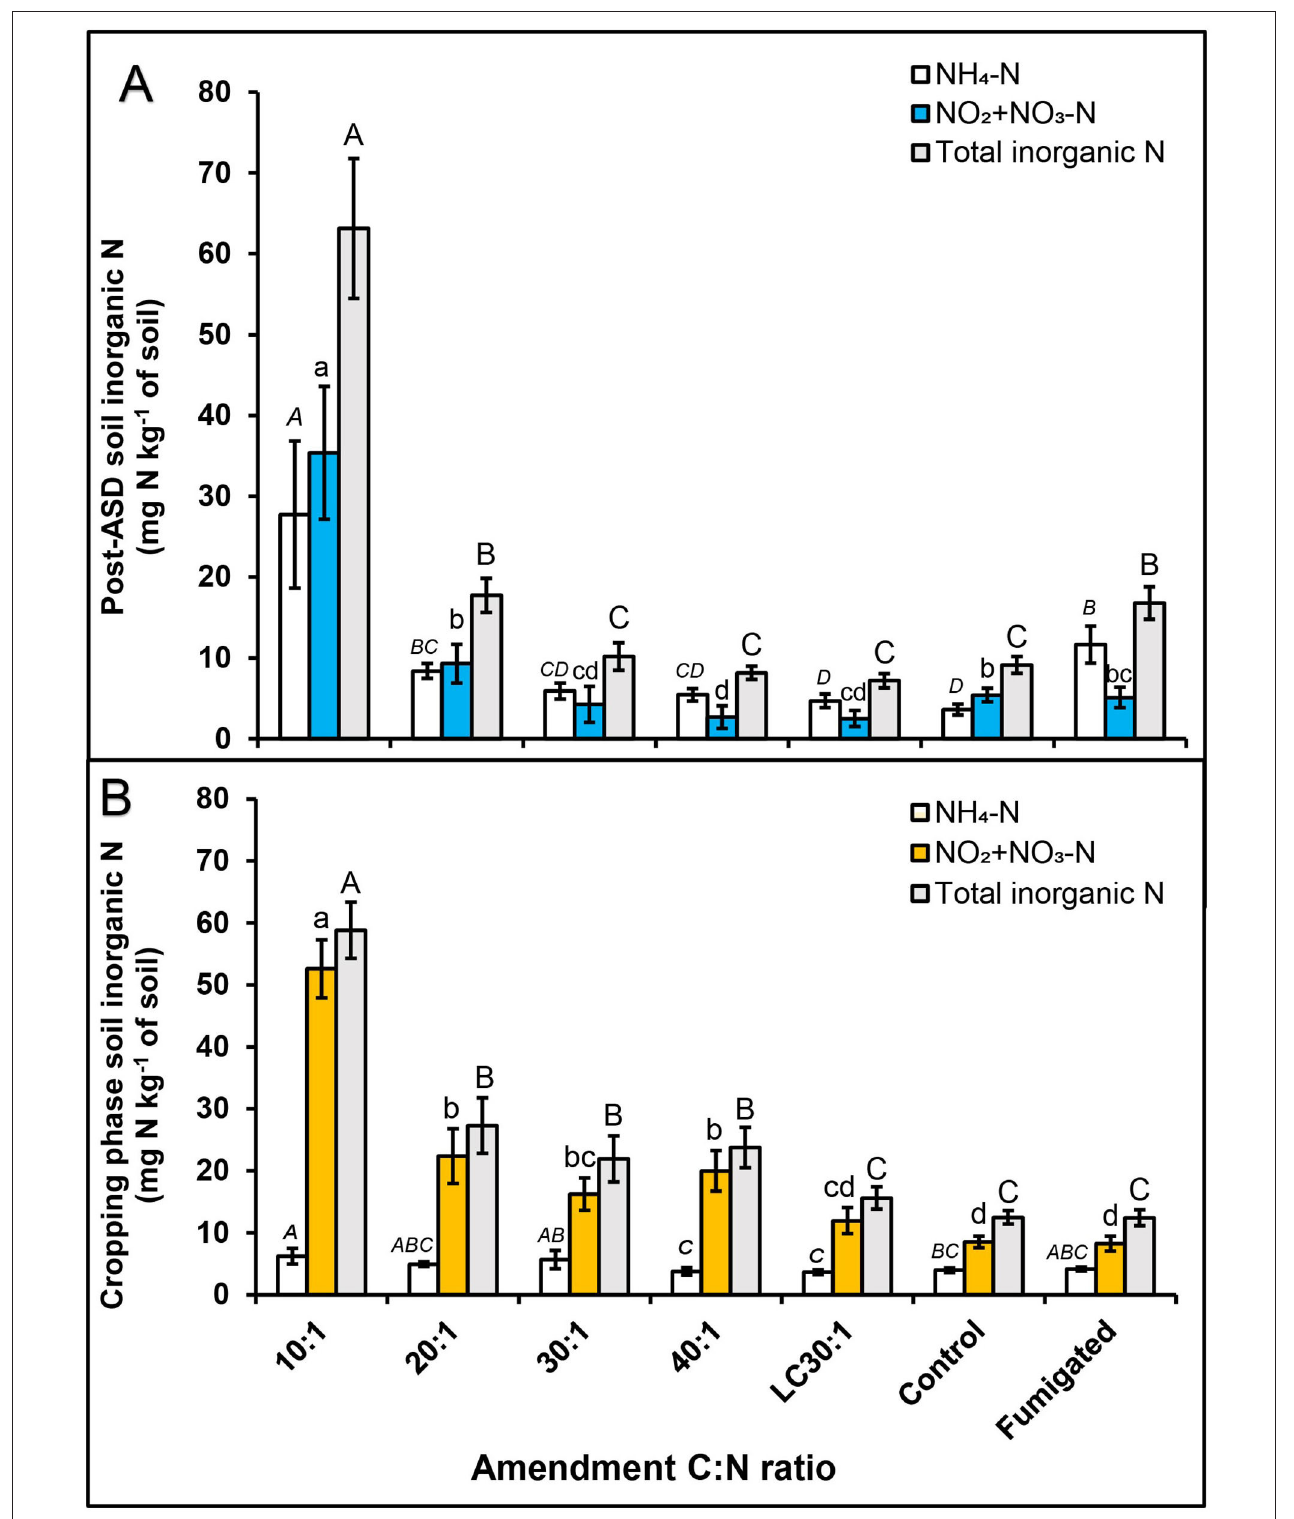
FIGURE 3 | Effect of dry molasses/soybean hull-based ASD amendment C:N ratio on soil inorganic N, (A) post-ASD treatment and (B) during cropping phase, trial 2. Bars indicated by similar letters for each category are not significantly different at P < 0.05 according to Fisher’s protected LSD test. Error bars indicate standard error with eight total replicates (4 replicates × 2 experiments). LC = Low carbon, Control = anaerobic, non-amended control, Fumigated = methyl bromide (MeBr) fumigated control (67:33 mixture with chloropicrin, 224kg ha − 1 ).